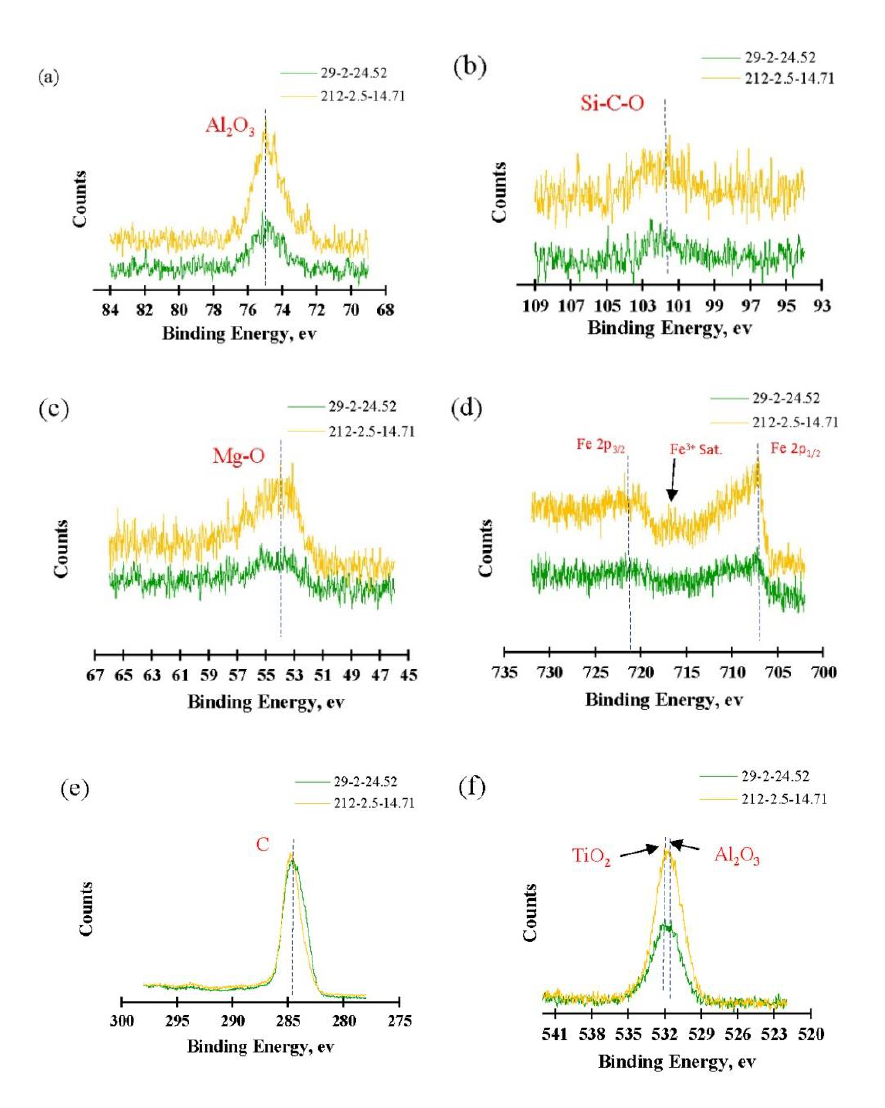
Fig. 9. XPS plots of composites at 9 h artificially aged, sliding speed 2 m/s, load 24.52 N (29-2-24.52) and 12 h artificially aged, sliding speed 2.5 m/s , 14.71 N load (212-2-14.71) (a) Al 2p, (b) Si 2p, (c) Mg 2p, (d) Fe 2p, (e) C 1s, (f) O